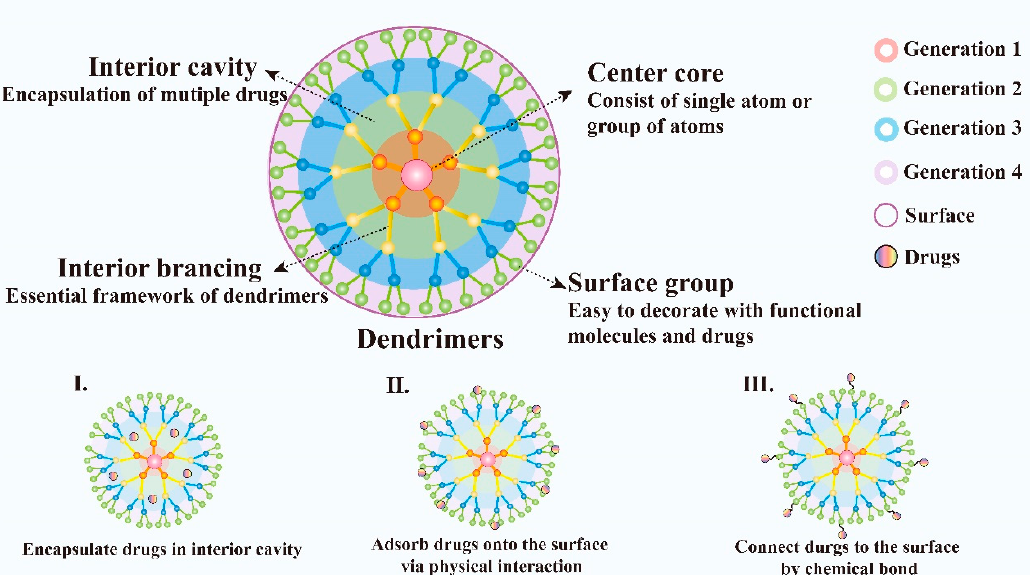
Figure 4. Schematic diagram of dendrimer architecture. Distinct functions of each dendrimer component and various ways of dendrimers to deliver drugs are also illustrated.